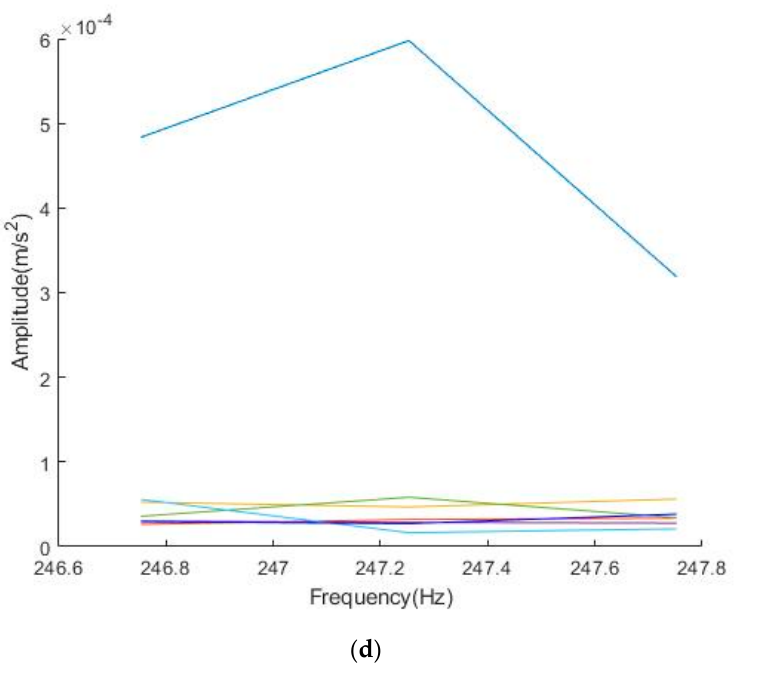
Figure 5. Frequency domain diagram after denoising: ( a ) global signals; ( b ) locally amplified signals-1; ( c ) locally amplified signals-2; ( d ) locally amplified signals-3.